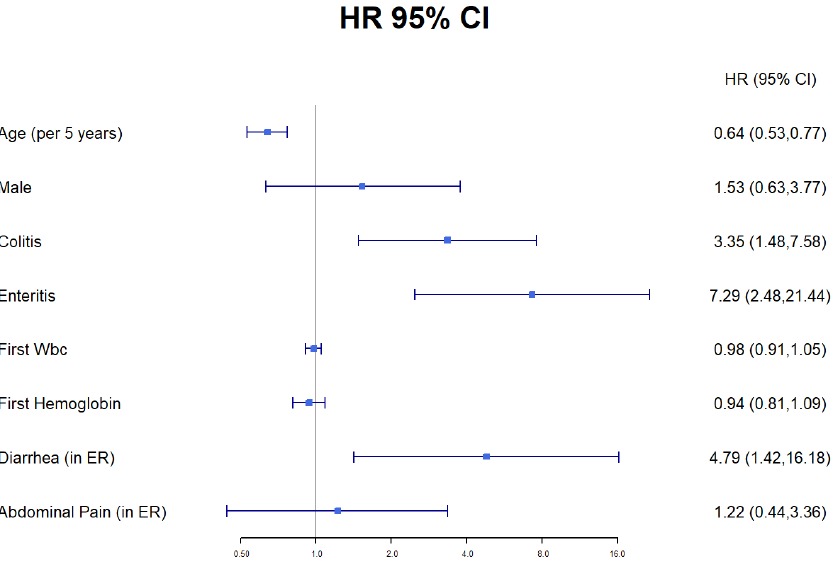
Figure 4. Multivariable analysis of factors associated with developing IBD. The only significant factors were age, diarrhea on presentation and enteritis or colitis on imaging (WBC—white blood cells). A second analysis was performed for all patients who visited the ED due to abdominal symptoms, not limited to those with a follow-up visit in the medical center. Overall, 25,282 patients visited the ED and underwent abdominal CT. After excluding those with a prior diagnosis of cancer, IBD or age above 70, a total of 1551 patients were included with a future IBD rate of 1.5% (23/1551). In this analysis, the abdominal imaging parameters associated with a future diagnosis of IBD were similar to the original cohort (ascend- ing colitis, transverse colitis, descending colitis, pan-colitis and enteritis). In addition, age ( p < 0.001) and diarrhea as a presenting symptom ( p < 0.001) were significantly associated with a future diagnosis of IBD. On multivariate analysis, age ( p < 0.001) and colitis on imaging ( p = 0.001) were associated with the development of IBD. 4. Discussion Diagnosing IBD based on a single episode of acute ileitis or colitis is challenging due to the chronic histopathological pattern of the disease necessary for the diagnosis. There- fore, defining risk factors for the likelihood of a future diagnosis of IBD is of clinical im- portance. This can assist us in defining the optimal follow-up of patients following an acute episode of bowel inflammation. In our study, approximately 4.7% of patients who presented to the ED with related symptoms and underwent abdominal CT with abnormal findings developed IBD in up to a nine-year follow-up time from the index visit. The pro- gression rates reported by previous studies were higher; nevertheless, these were assessed in asymptomatic patients with incidentally diagnosed terminal ileitis on endoscopies. Zhang and colleagues reported a 20% (7/34) progression rate to overt CD [12]. Two addi- tional studies reported 9% (3/32) and 14% (6/43) progression rates to CD, with a median follow up time of 38.4 months (range 1 – 61) and 40 months (range 4 – 106), respectively [9,21]. However, all the above studies explored progression of asymptomatic patients with isolated terminal ileitis on endoscopies, whereas our study examined patients with an acute episode of characteristic clinical and radiographic manifestations. Tse and col- leagues examined patients undergoing diagnostic ileocolonoscopy due to unexplained gastrointestinal symptoms or abnormal abdominal imaging findings. Among these pa- tients with endoscopic isolated acute terminal ileitis, 4.6% of patients were eventually di- agnosed with CD [10]. Although the selected cohort and the progression rates were rela- tively similar to our study, the additional diagnostic tier of endoscopy and histology